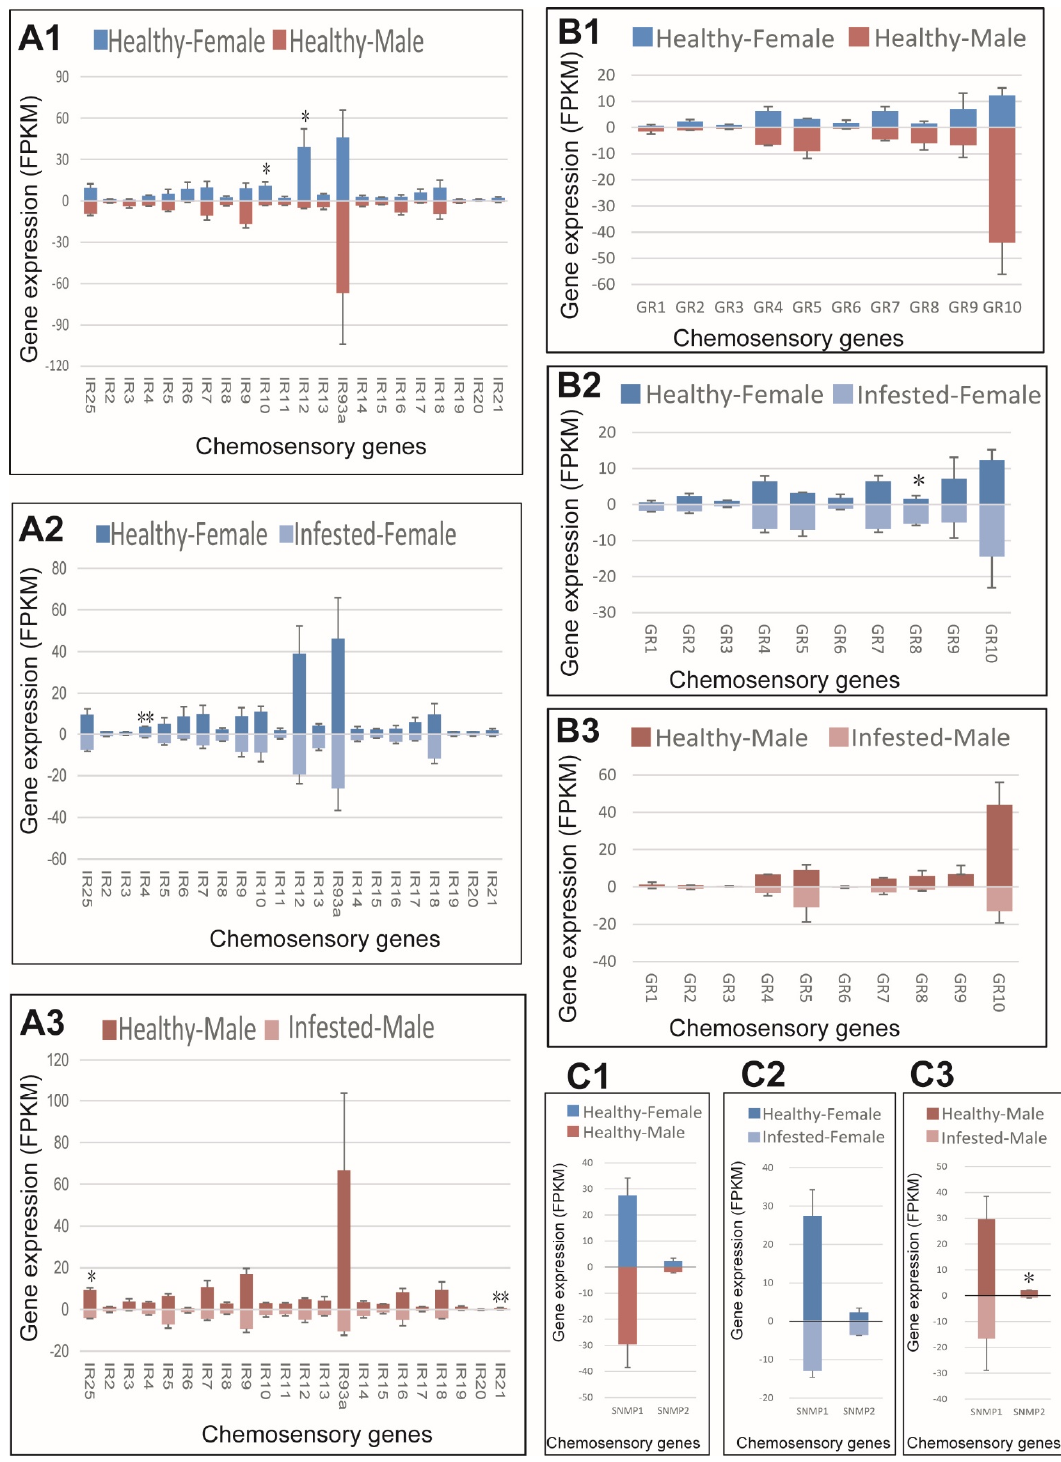
Figure 7. Expression patterns of ionotropic receptors (IRs), gustatory receptors (GRs), and sensory neuron membrane proteins (SNMPs) in healthy and B. xylophilus -infested M. saltuarius . ( A1 ), IRs expression differences between sexes of healthy M. saltuarius ; ( A2 ), IRs expression differences between healthy and infested female M. saltuarius ; ( A3 ), IRs expression differences between healthy and infested male M. saltuarius . ( B1 ), GRs expression differences between sexes of healthy M. saltuarius